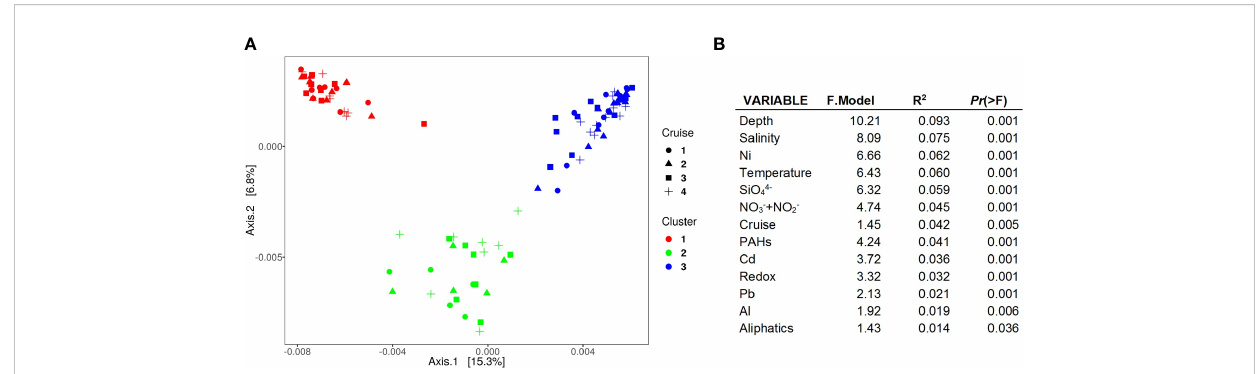
FIGURE 3 Community structure analysis. (A) PCoA ordination of the community structure dissimilarity based on weighted UniFrac distance. (B) Results of the permutational multivariate analysis of variance. Environmental variables signi fi cantly ( P <0.05) related to microbial community structure